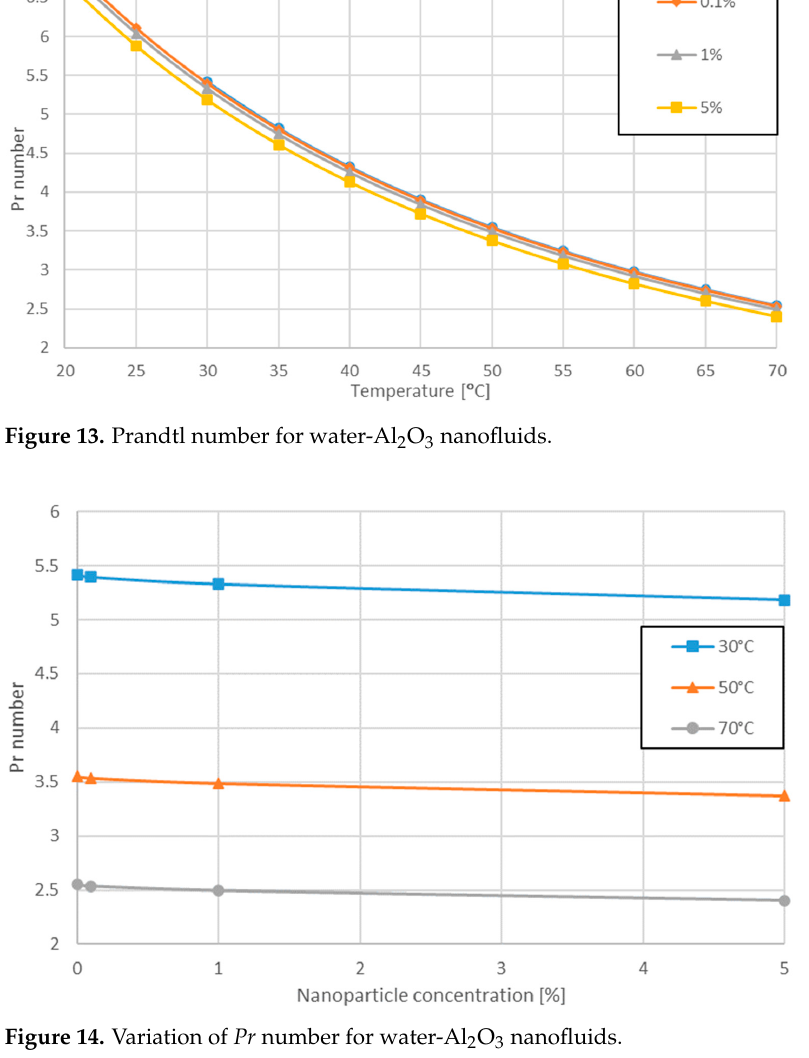
Figure 14. Variation of Pr number for water-Al 2 O 3 nanofluids.